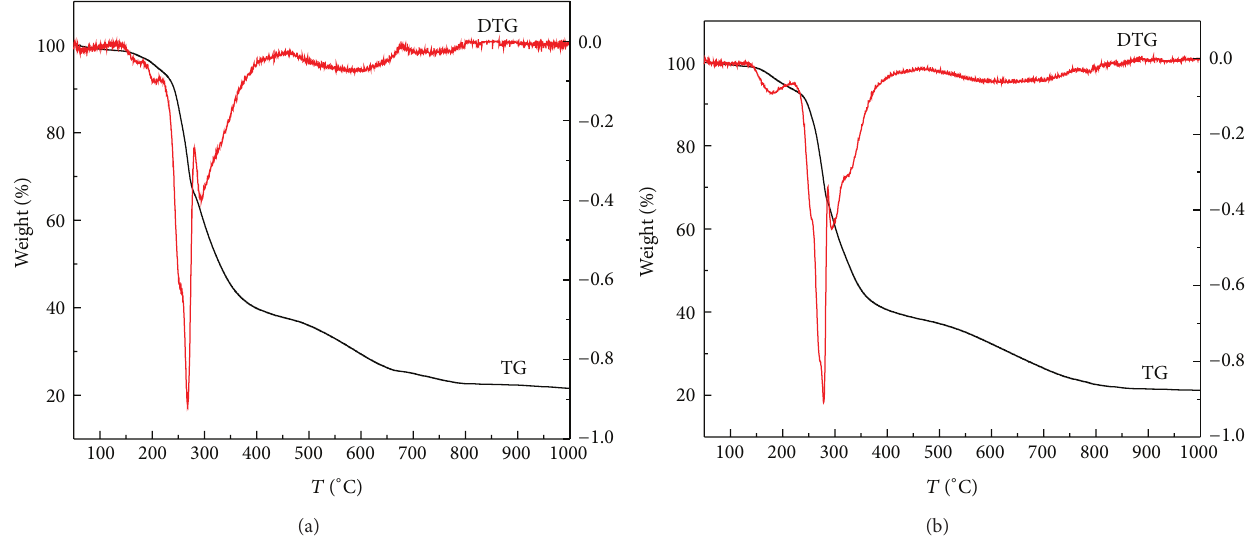
Figure 1: TG/DTG curves of the gel precursor of (a) LiNi 1/3 Co 1/3 Mn 1/3 O 2 and (b) LiNi 1/3 Co 1/3 Mn 1/3 O 2−0.10 Cl 0.10 .